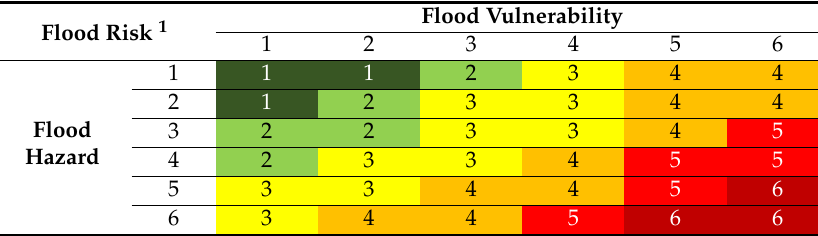
Table 3. Flood potential risk matrix for cultural heritage sites. Flood Risk